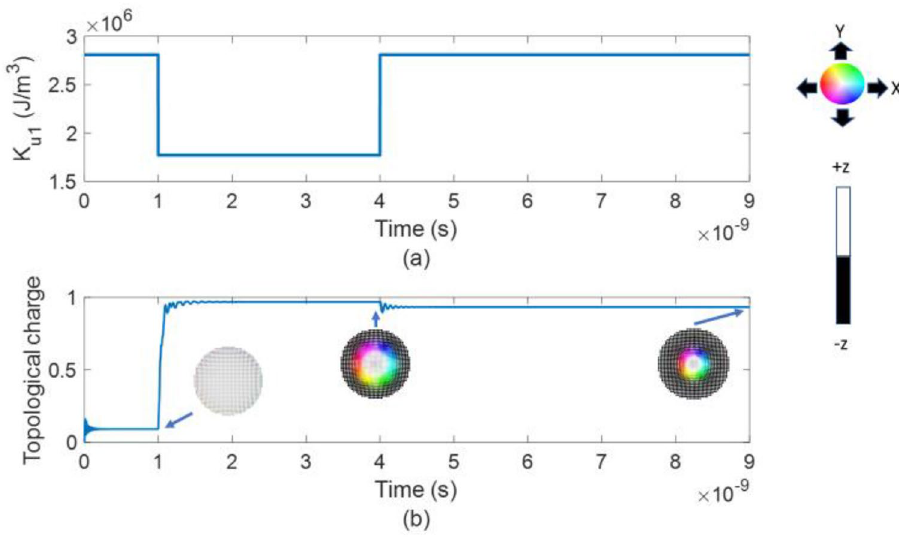
Figure 1. ( a ) Application of VCMA, ( b ) A quasi-ferromagnetic (QFM) state is created after relaxing for 1 ns. After the reduction of PMA, a skyrmion is formed and it is stable even after the withdrawal of voltage